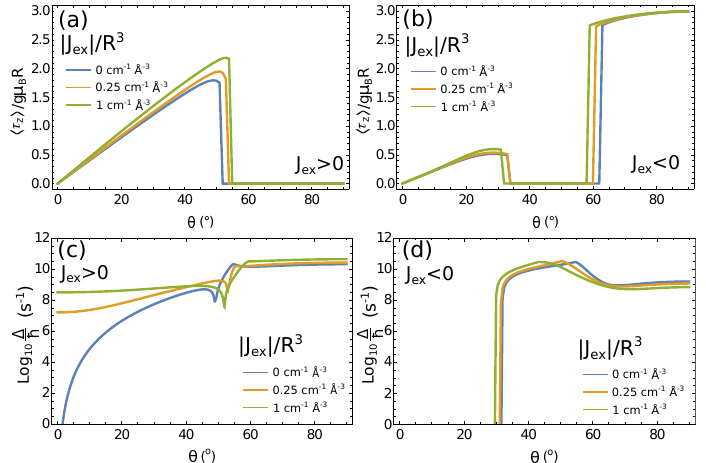
Figure 4. ( a , b ) Toroidal moment expectation value computed on the quasi -degenerate ground mani- fold of the triangle with ( a ) ferromagnetic and ( b ) antiferromagnetic exchange coupling for varying strengths of magnetic dipole–dipole interaction. ( c , d ) Tunnelling rate of the ground-state toroidal moment as a function of canting angle θ for the on-site S = 1 molecular triangle with a fixed ratio of | D / J ex | = 10 and with magnetic dipole–dipole coupling included between paramagnetic sites in the ring. The tunnel splitting is shown for several dipole–dipole coupling strengths and for ( c ) ferromagnetic and ( d ) antiferromagnetic Heisenberg exchange